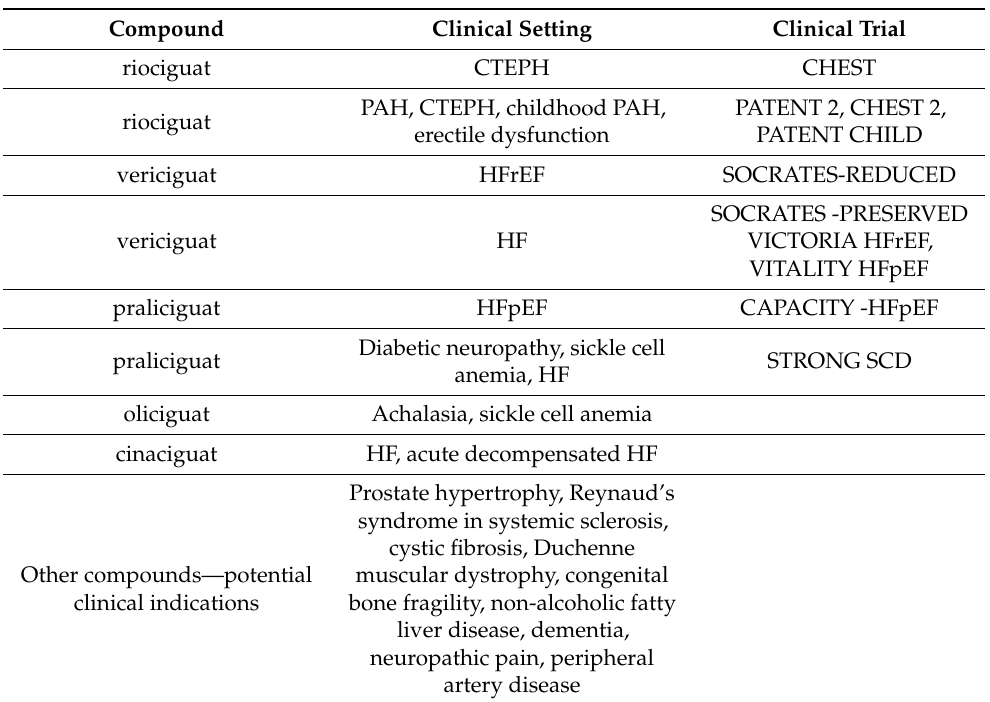
Table 1. Research directions using sCG activators in medicine